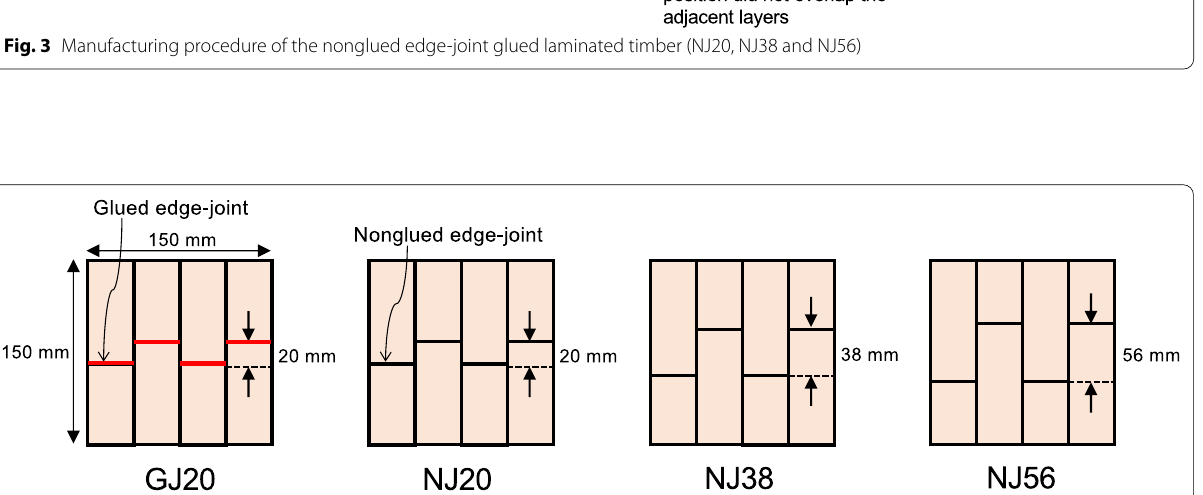
Fig. 4 Cross-sectional view of the manufactured glued laminated